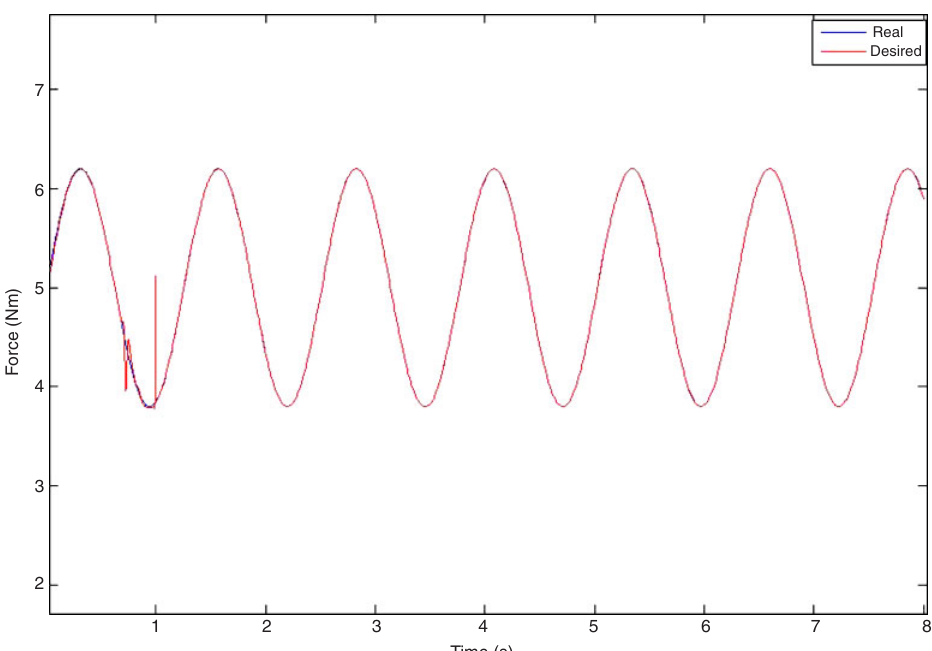
Figure 7 Contact force, real and desired (tracking in t b = 1